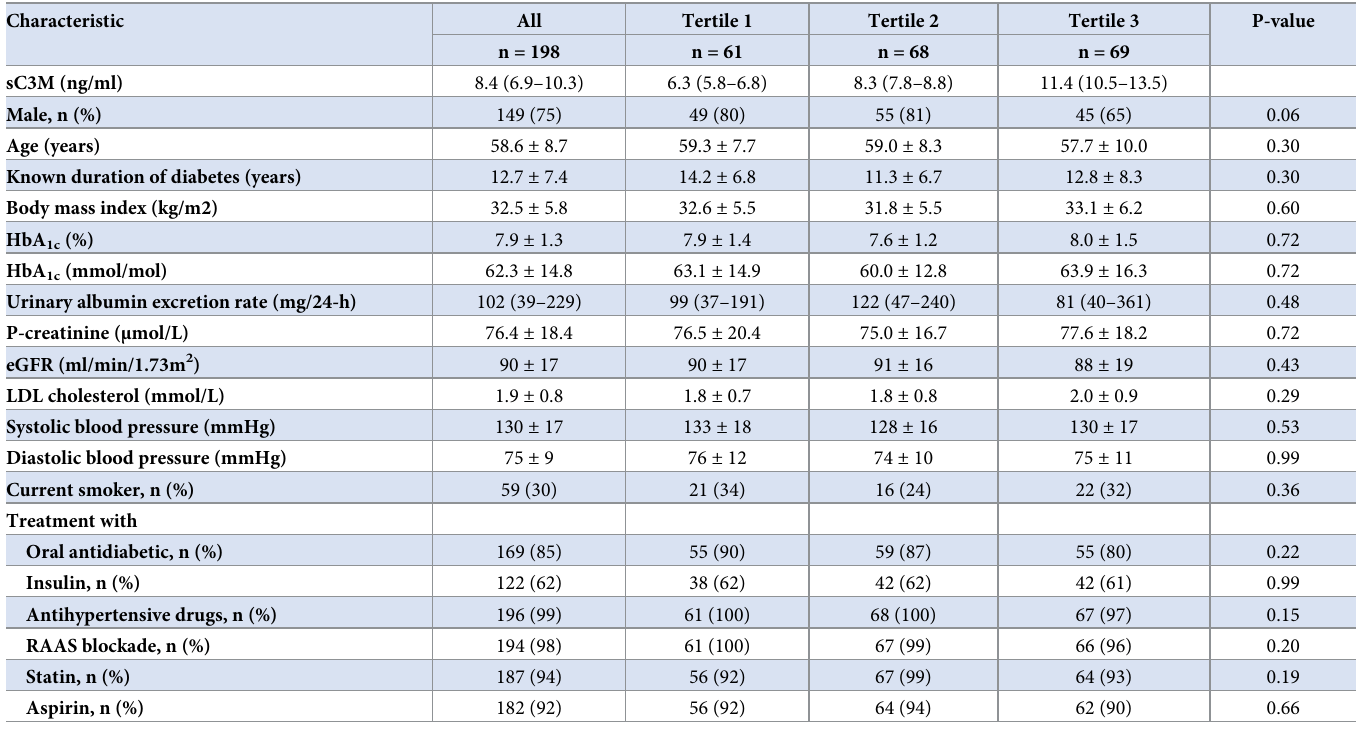
Table 1. Baseline characteristics of the total population and stratified by sC3M